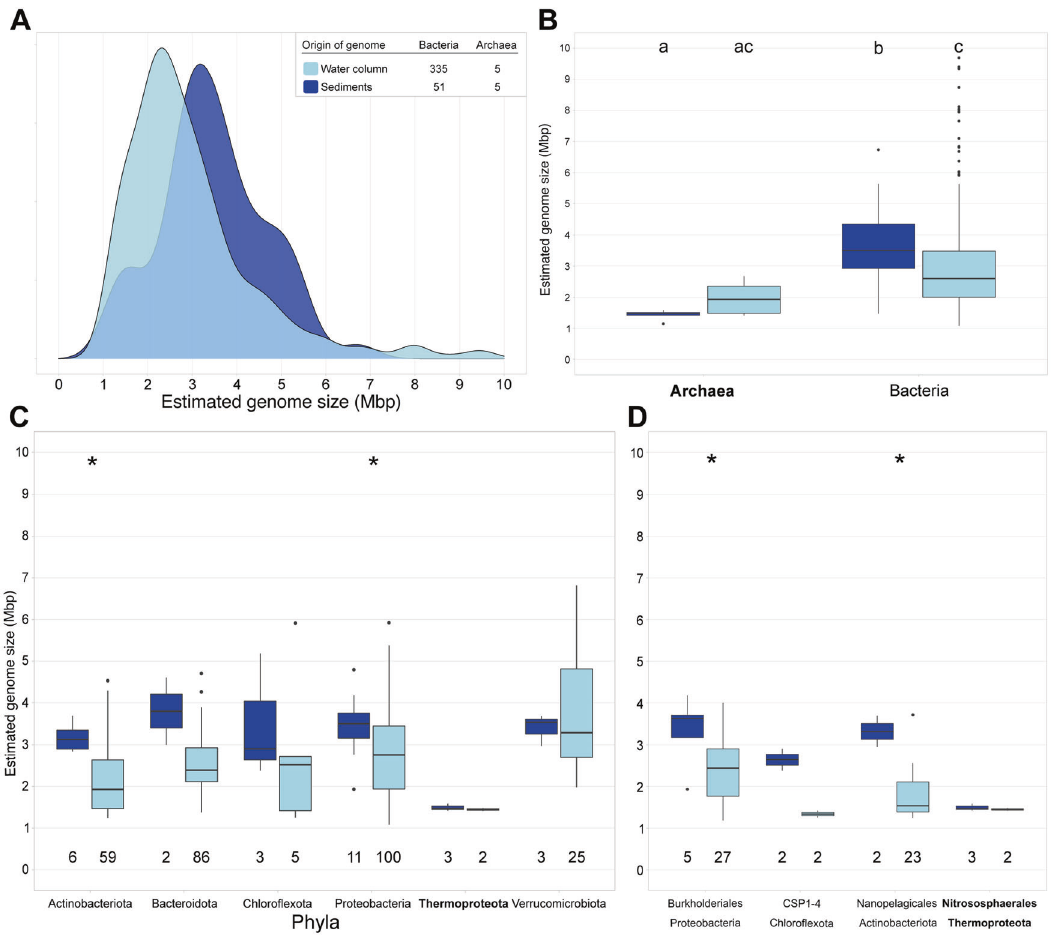
Fig. 3 Overview of the estimated genome size in bacteria and archaea obtained from Baltic Sea sediments (dark blue) and water column (light blue) using only the 397 representative MAGs (95% average nucleotide identity) with >75% completeness. A Shows the genome size distribution of archaea and bacteria obtained from Baltic water column and sediments for a total of 397 representative genomes. B Shows the estimated genome size per domain and environment. Different letters indicate signi fi cant differences p < 0.05 (Kruskal-Wallis non- parametric test; multiple testing corrected with Benjamini-Hochberg). C Shows the estimated genome size per phylum. We selected only phyla with at least 2 MAGs in each environment. D Shows the estimated genome size per order. We selected only orders with at least 2 MAGs in each environment. Numbers below the boxes indicate the number of MAGs per environment. Stars in Panel C and D indicate signi fi cant differences p < 0.05 (Wilcoxon non-parametric